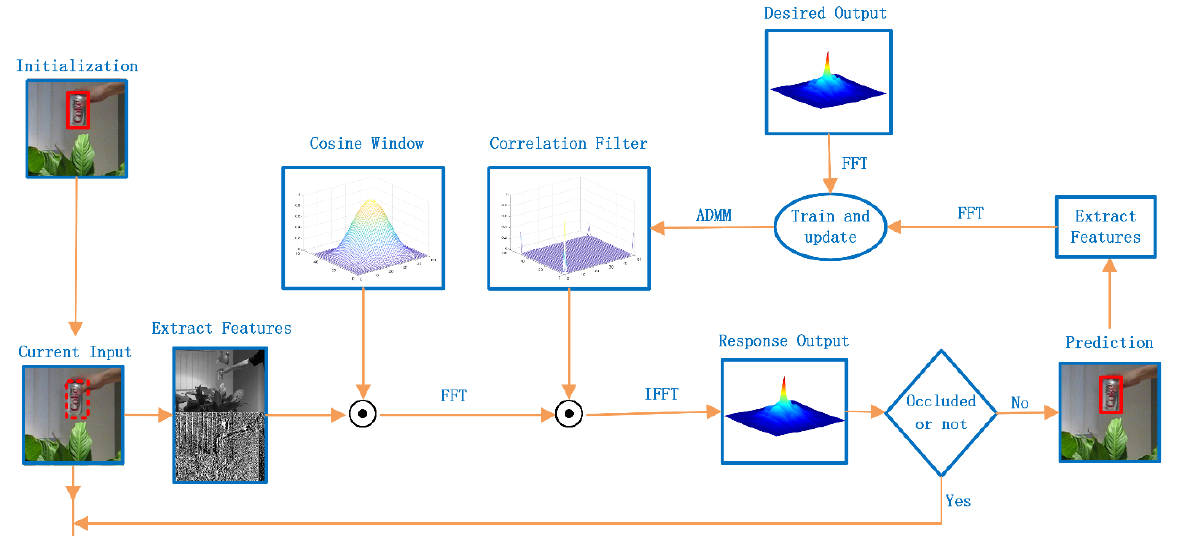
Figure 1. The tracking flow diagram of the FSRCF tracker.